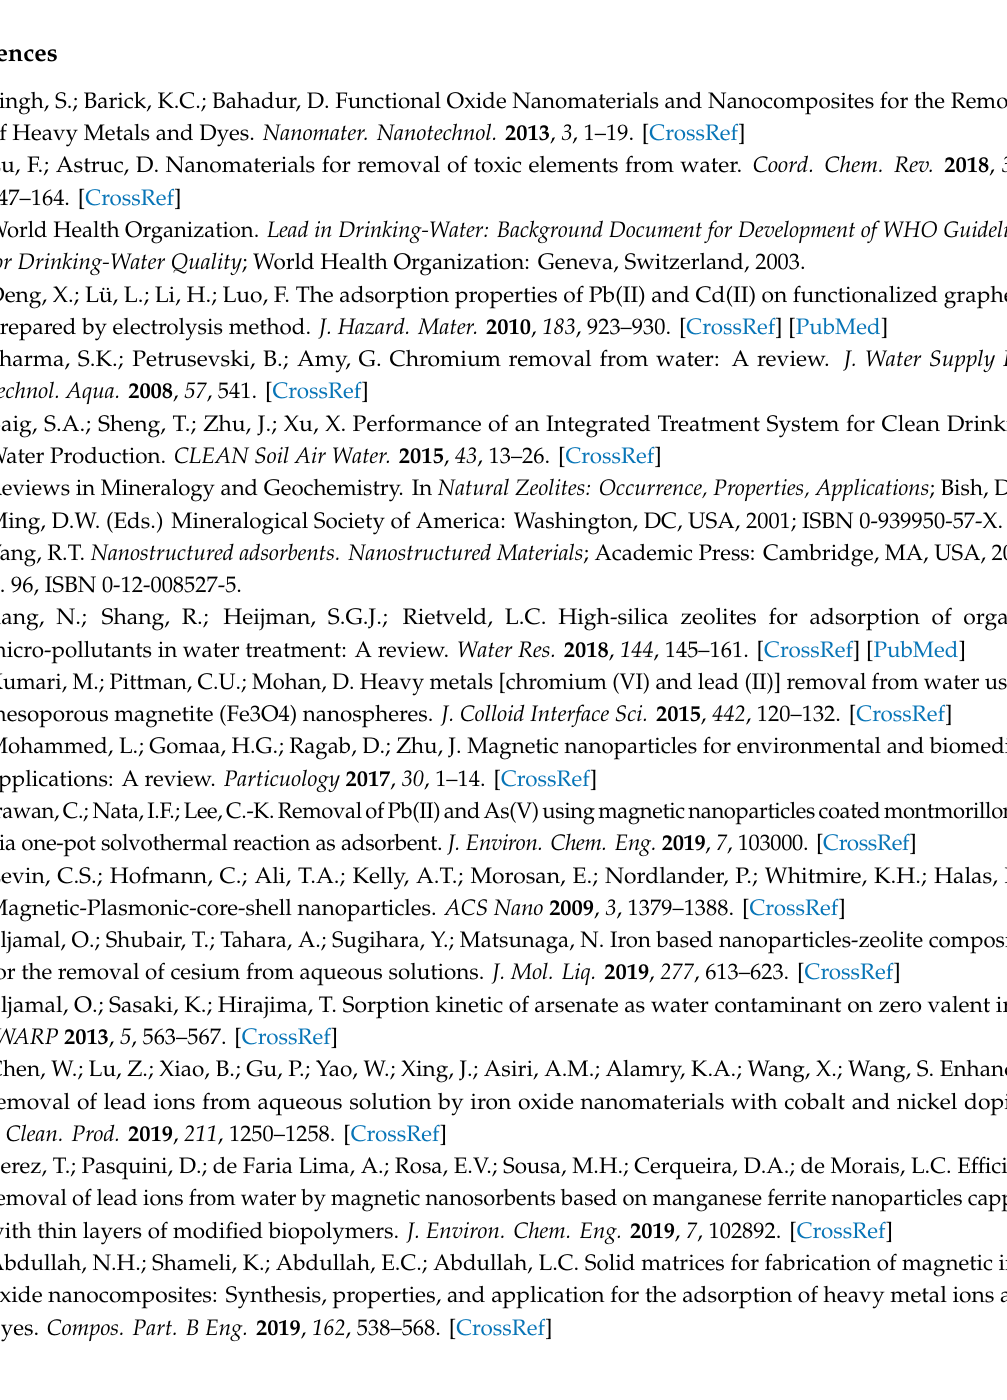
Figure S1: Scherrer plot; Figure S2: W–H plot; Figure S3: modified W–H plot; Figure S4: modified W–H plot; Figure S5: SSP plot; Figure S6: Speed agitation dependence of the removal efficiency; Table S1: Microstructural